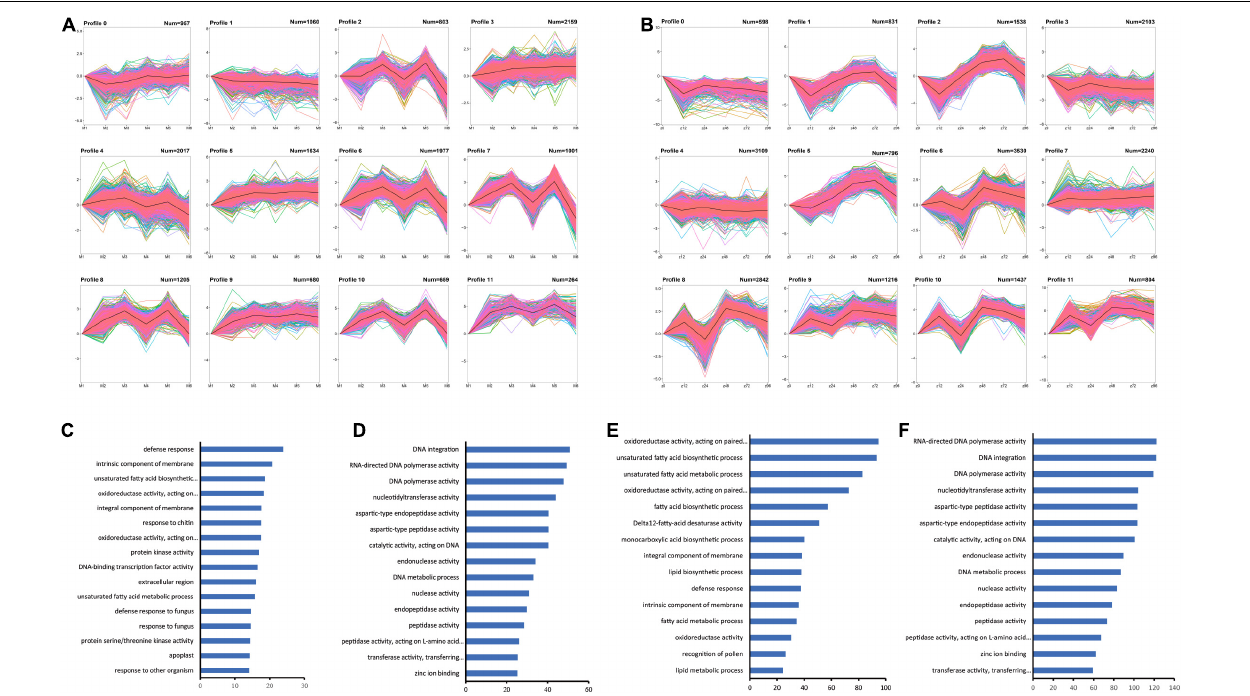
FIGURE 3 | K -means clustering of DEGs in MK and ZC. (A,B) Twelve clusters of MK (A) and ZC (B) DEGs based on FPKM values. (C–F) GO term enrichment of the DEGs in MK profile 3 (C) , MK profile 7 (D) , ZC profile 7 (E) , and ZC profile 10 (F) . The data were calculated by –log 10 ( p -value).